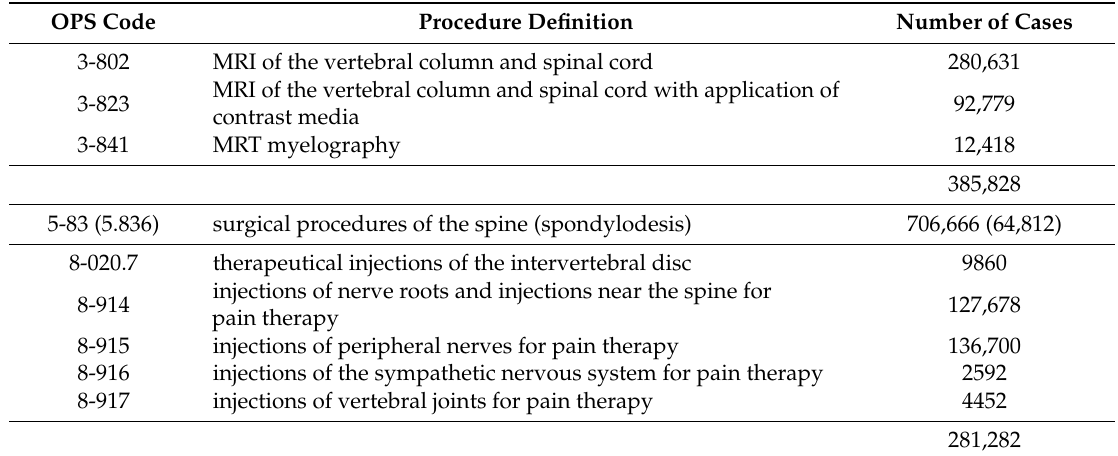
Table 3. Number of procedures of inpatient treatment between 2014 and 2015 according to the German Procedure Classification System (OPS) 1